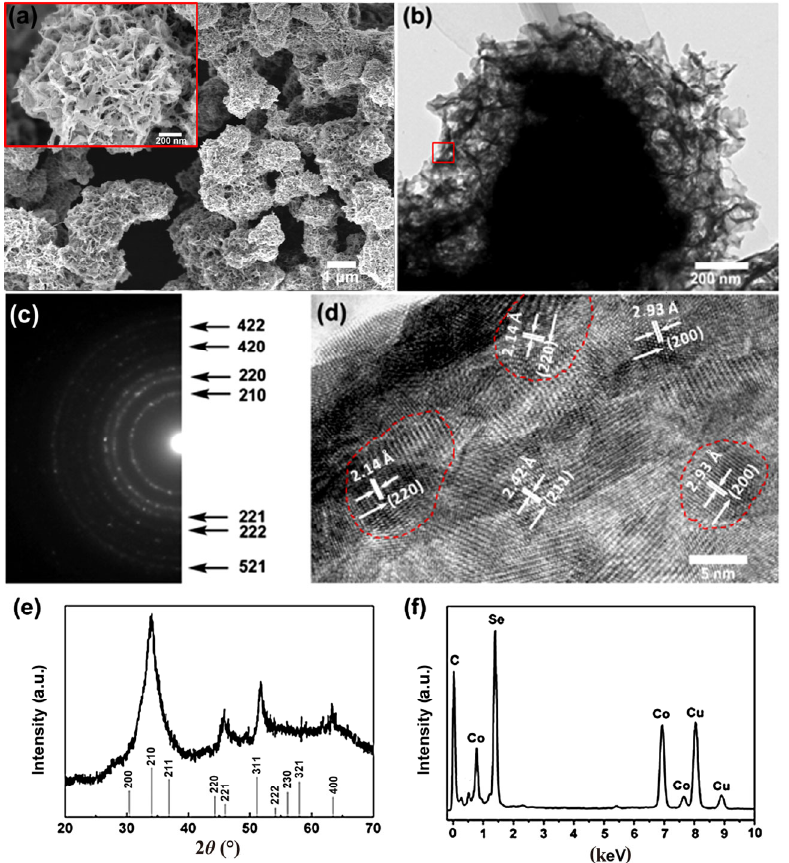
Fig. 1 (a) Low- and high-resolution SEM images, (b) TEM image, (c) SAED pattern, (d) HRTEM image, (e) XRD pattern, and (f) EDS spectrum of the hierarchical clew-like CoSe 2 microstructure, which is prepared with 1.5 mmol CTAB in 40 mL solvent = 2:1) at 180 ℃ for 16 h (Sample ( V DETA / V H 2 O